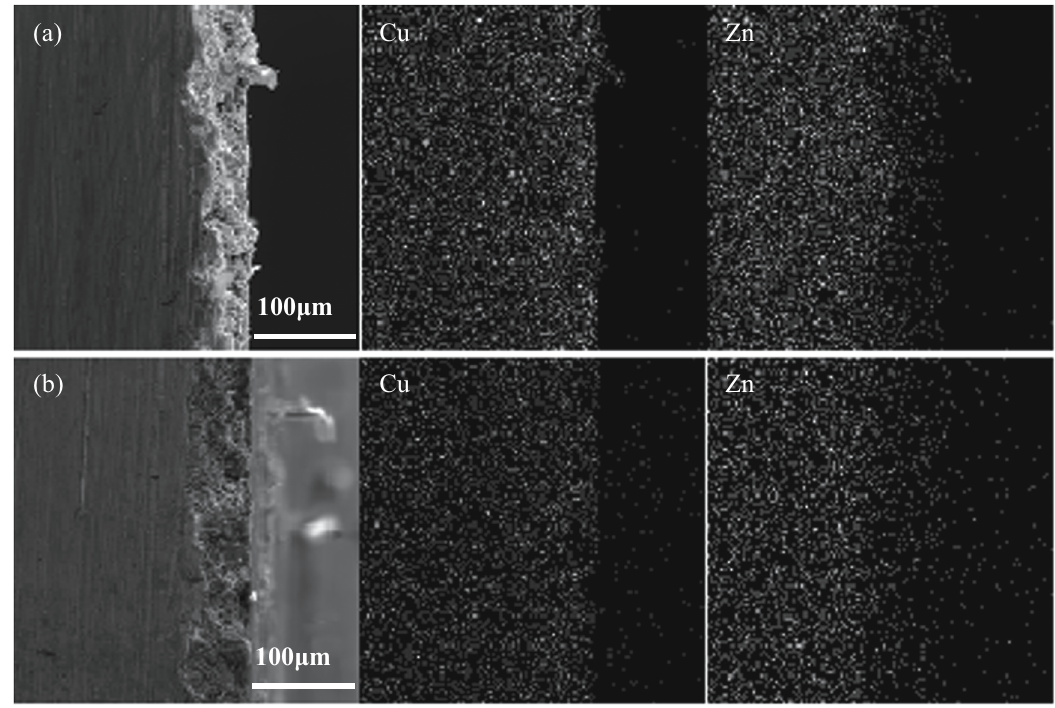
Figure 5: Element distribution analysis of brass alloy with and without corrosion ( a ) original sample and ( b ) with